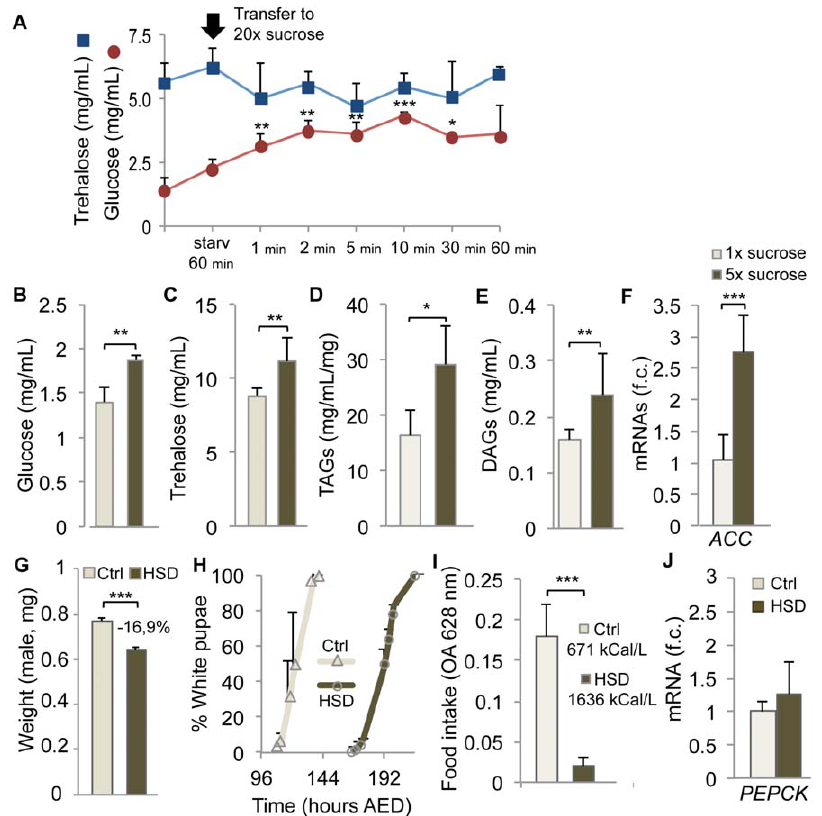
Figure 1. Metabolic and growth defects induced by High Sugar Diet. (A) After 60 9 of starvation, L3 larvae were transferred on high sucrose (20 6 in PBS), and the levels of circulating glucose and trehalose were monitored from 1 9 to 60 9 after transfer, revealing a modification of glucose levels, but not trehalose. Note that the starvation before transfer to 20 6 sucrose induces itself a slight increase in basal glycemia. (B) Glucose and (C) trehalose levels as measured in the hemolymph of wandering larvae fed from eclosion on 1 6 or 5 6 sucrose diet. (D) Total triacylglycerides (TAGs) and (E) circulating DAGs in larvae fed on 1 6 and 5 6 sucrose diet after eclosion. (F) Effect of 1 6 or 5 6 sucrose diet on the rate of transcription of the ACC gene in mid-L3 larvae. (G) Weight of adult males emerged after larvae were fed on 1 6 (ctrl) or 5 6 sucrose diet (High Sugar Diet, HSD). (H) Effect of control diet or HSD on the developmental timing, assessed at the time of white pupa formation. (I) Measurement of food intake of L3 larvae previously fed on ctrl diet or HSD, as measured by blue food ingestion. (J) Differential expression of the PECK gene on ctrl diet or HSD in mid-L3 larvae.